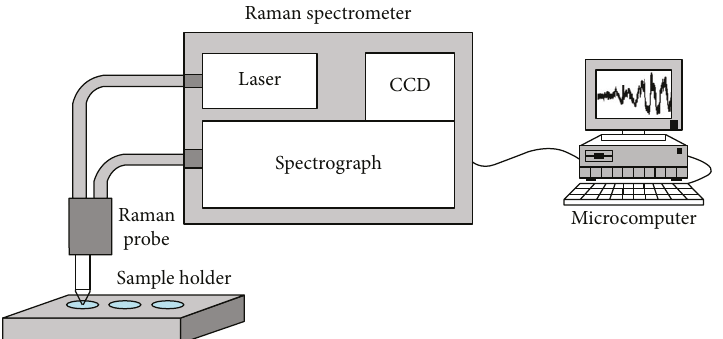
Figure 1: Schematic diagram of the dispersive Raman spectrometer used in the experiment. Laser power measured at the Raman probe tip: 250mW, wavelength: 830 nm, spectrometer resolution in the 400 – 1800cm − 1 range: 2cm − 1 .